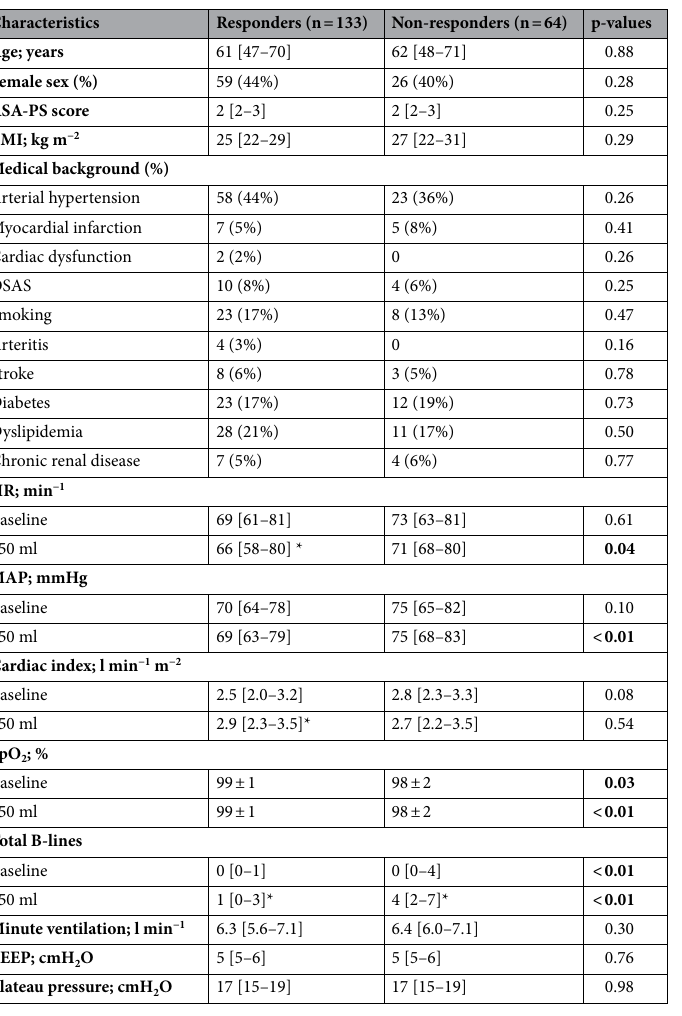
Table 1. Comparison of baseline characteristics, hemodynamic, echography, and ventilation parameters, at baseline and after the first fluid challenge of 250 ml, between responding and non-responding patients. Significant values are in bold. Values are means ± SD, numbers (proportion) or median [IQR]. ASA-PS American Society of Anesthesiology-Physical status, BMI body mass index, HR heart rate, MAP mean